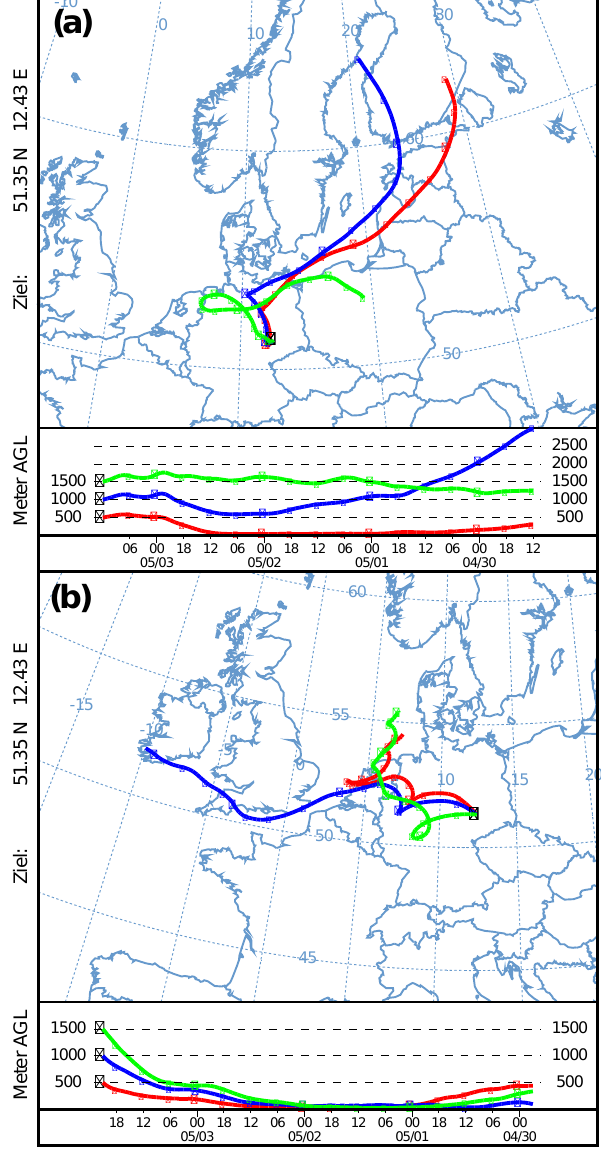
Leipzig on 3 May 2009, 12:00UTC (a) , and 21:00UTC (b) .